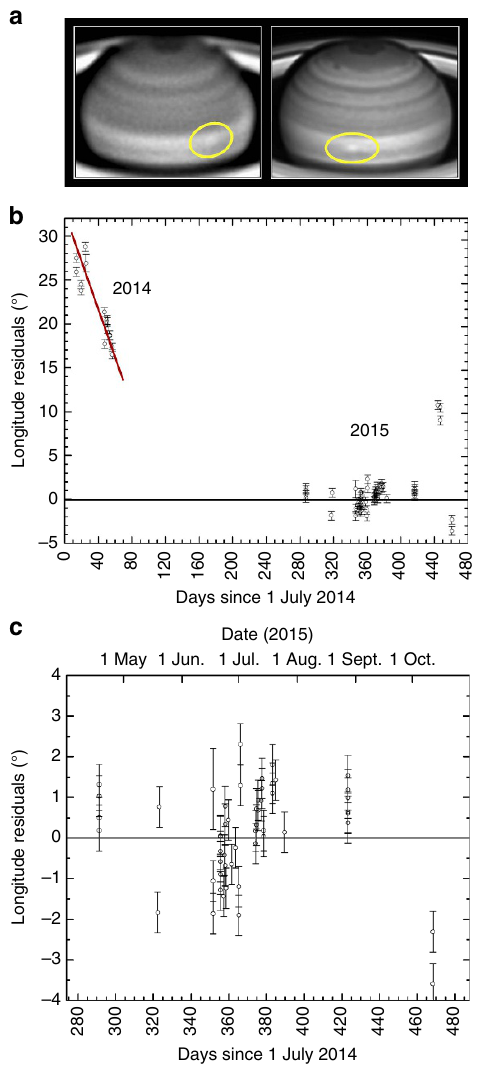
Figure 2 | Ground-based images and motion of Saturn’s white spot in 2014–2015. ( a ) June 21 (left, Aula EspaZio 28cm telescope, wavelength 615–950nm) (ref. 29) and July 13 (right, PlanetCam at the 2.2m telescope Calar Alto Observatory, 750–950nm (ref. 30)); ( b ) Residuals in the longitude position of spots measured relative to a reference system rotating with a period of 10h 11min 26.3s (horizontal black continuous line), found from the mean zonal drift of white spot between 18 April and 12 October 2015 ( (cid:2) 37.05 (cid:2) per day in System III (ref. 31) or u ¼ 447ms (cid:2) 1 ). ( c ) Detail of the residuals in longitude measured in 2015. The error bar of each individual longitude measurement is given by the image resolution at the location of the spot in the disk (typically 1 (cid:2) mean speed of both spots with an accuracy of ± 1 ms (cid:2) 1 . With the data in hand, we cannot definitively conclude if the 2014 white spot changed slightly its drift velocity (being the same as the 2015 white spot feature), or if these are different spots which emerged separated in time but at close longitudinal positions. In both cases, these speeds are well above the 380ms (cid:2) 1 measured during the Cassini epoch at this latitude 8,9 . These high speeds at the Equator were only observed in 1980–1981 (ref. 7) during the Voyager flybys (Fig. 1), suggesting one of the following possibilities: the spot is at a deeper level where faster winds are present 15,32 , or a change in the jet system have occurred since the last accurate wind measurements based on Cassini ISS data in 2009.